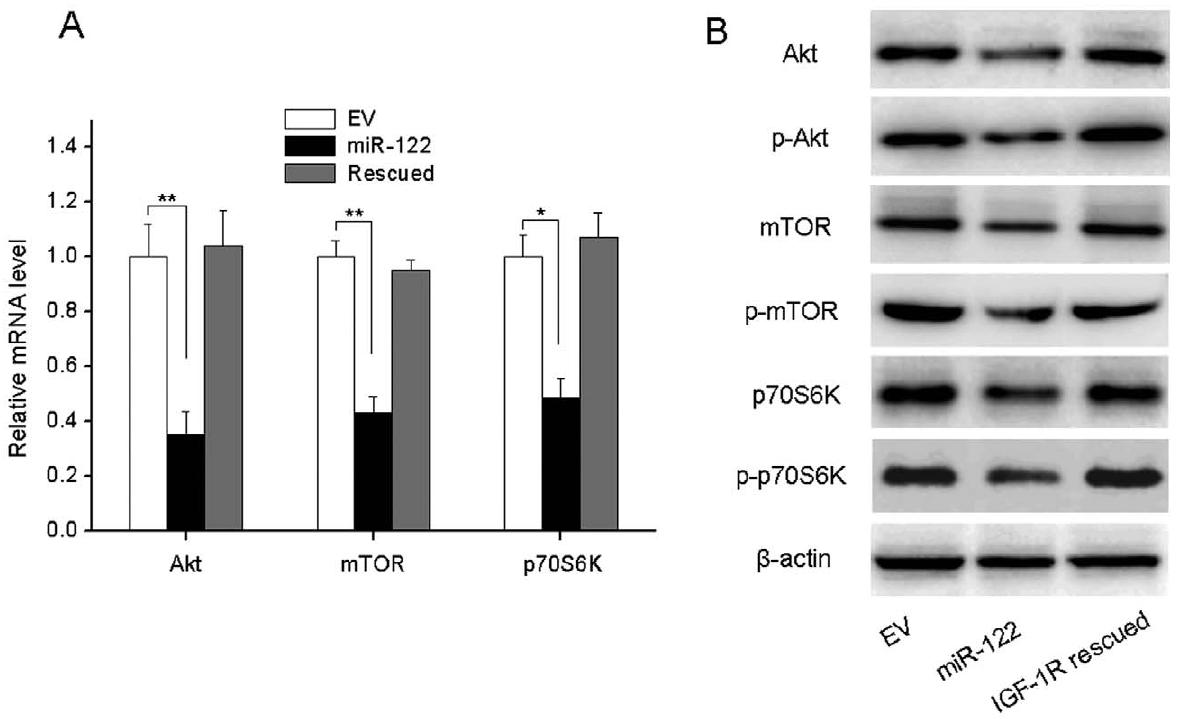
Figure 5. Overexpression of miR-122 alters the expression of key components in the PI3K/Akt/mTOR/p70S6K signal pathway. (A) miR-122-overexpression significantly suppressed the PI3K/Akt/mTOR/p70S6K pathway examined by qRT–PCR (A) and Western blot (B). The inhibition of PI3K/Akt/mTOR/p70S6K was reversed by re-expression of IGF1R (IGF1R rescued) in miR-122 group. All experiments were carried 3 times independently. *P , 0.05 compared to EV group. **P , 0.01 compared to EV group.